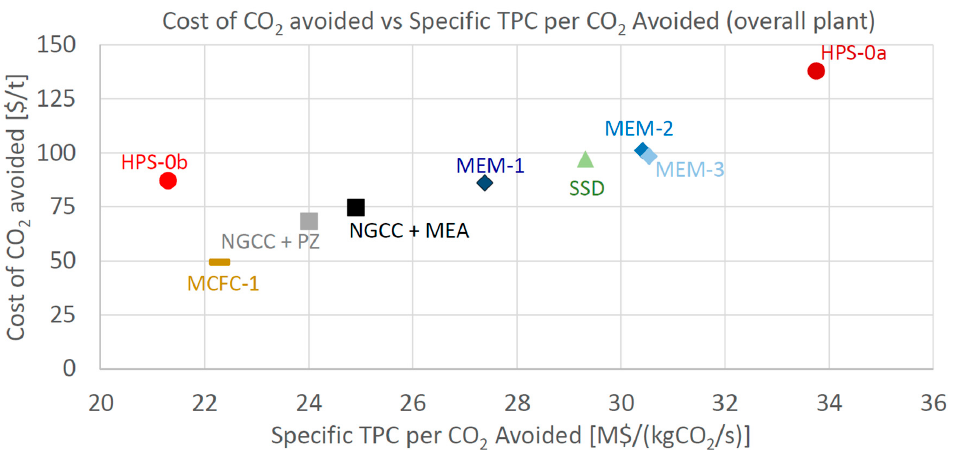
Figure 9. Cost of CO 2 avoided vs. Specific TPC per CO 2 avoided.